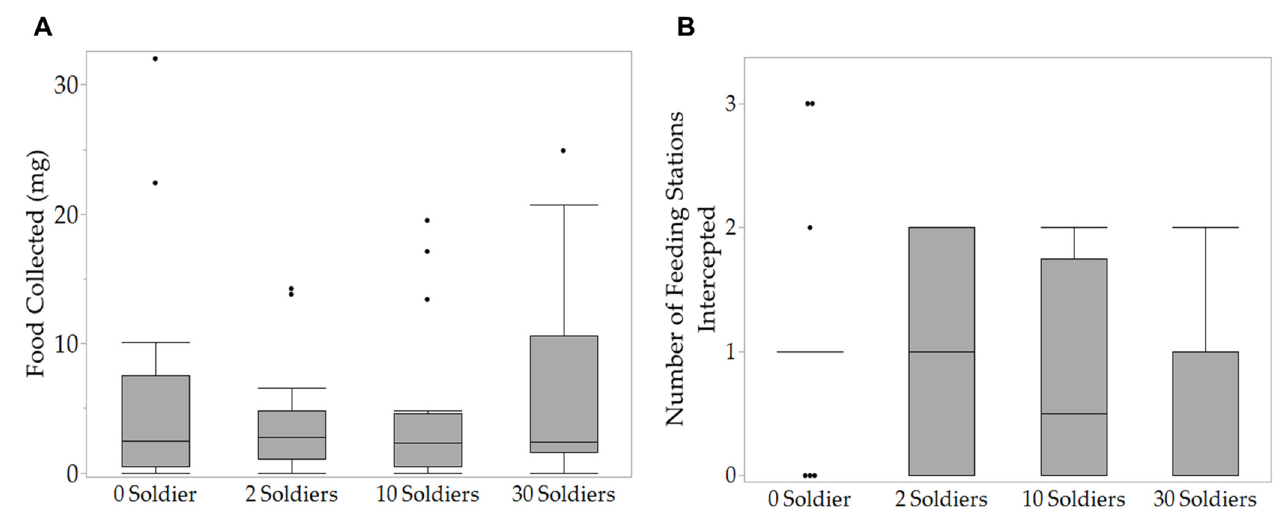
Figure 4. ( A ) Total food collection and ( B ) number of feeding stations intercepted in 96 h by groups of 100 foraging workers with different numbers of soldiers. Boxes are bounded by the 25th and 75th percentiles, bands are medians, whiskers represent minimum and maximum values, and dots outside of whiskers are outliers. No significant difference was detected among treatments (food collection: ziG-GLMM, p > 0.05; number of feeding stations intercepted: ziB-GLMM; p > 0.05, n = 16).